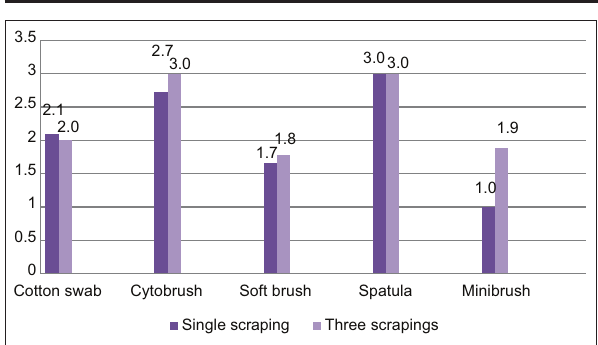
Figure-3: Sample quality. Aggregates, mucus, and artifacts where 1+ = fair amount, 2+ = moderate amount, and 3+ = high amount.